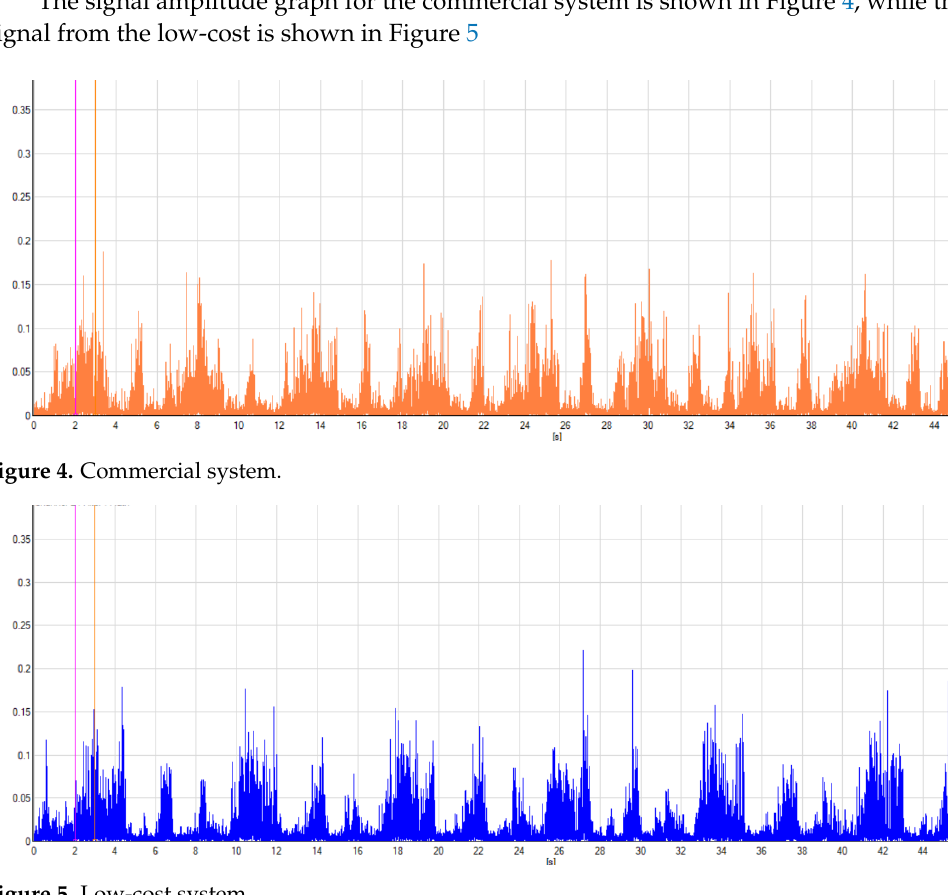
Figure 5. Low-cost